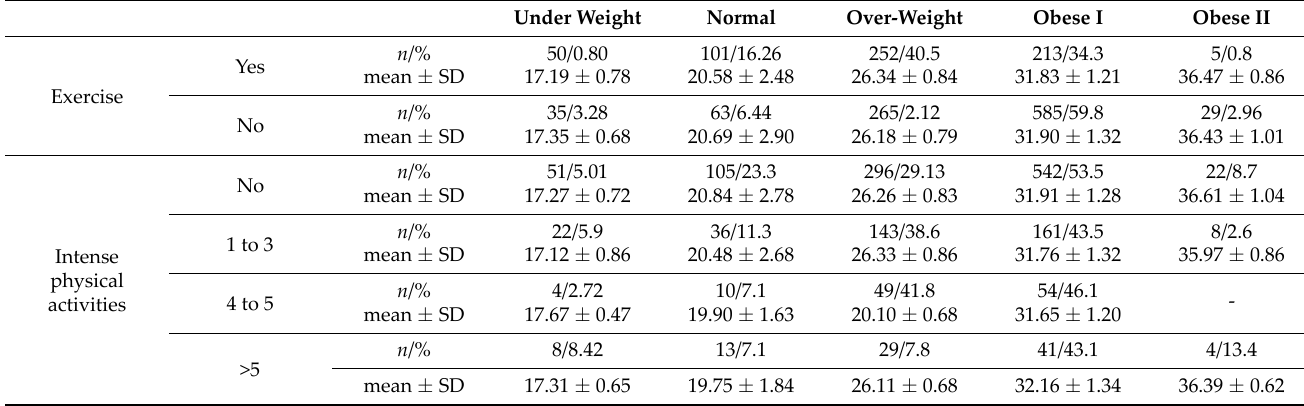
Table 6. Differences in body mass index according to physical